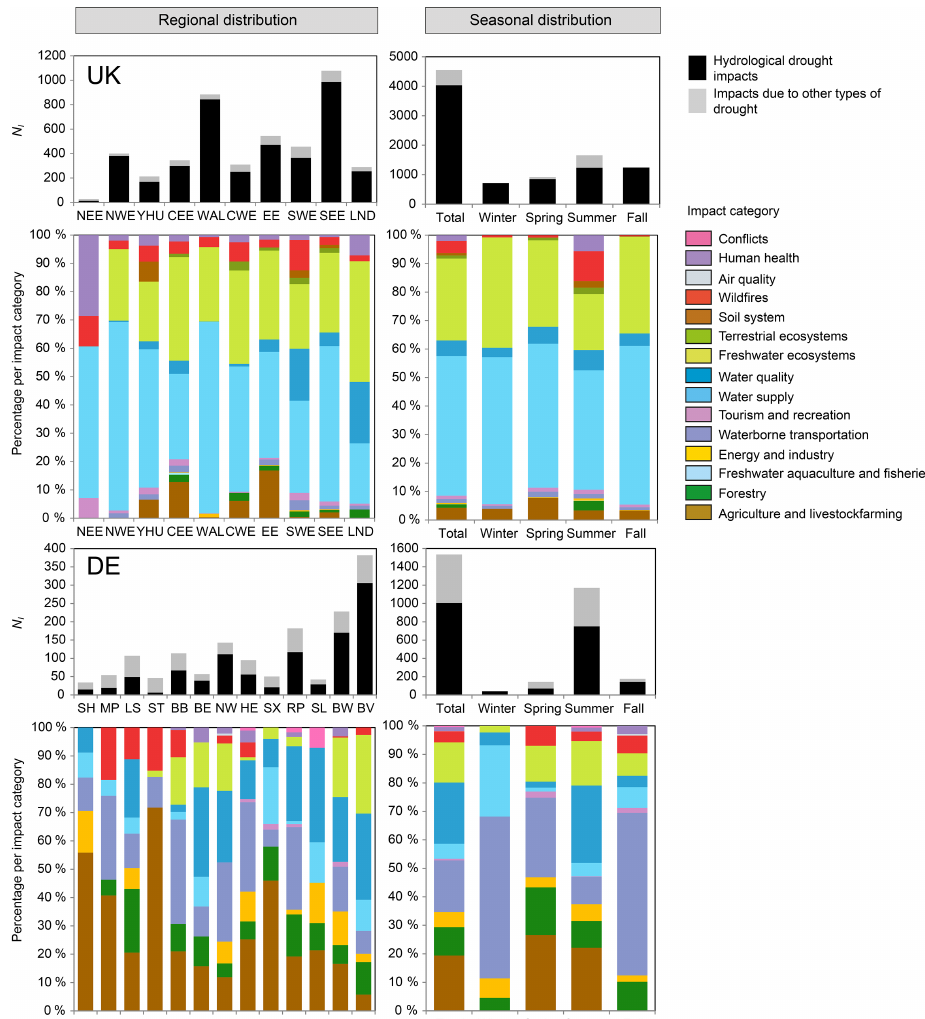
Figure 2. Number of impact occurrences and distribution of impact categories for each NUTS1 region and season for the UK (top four plots) and Germany (bottom four